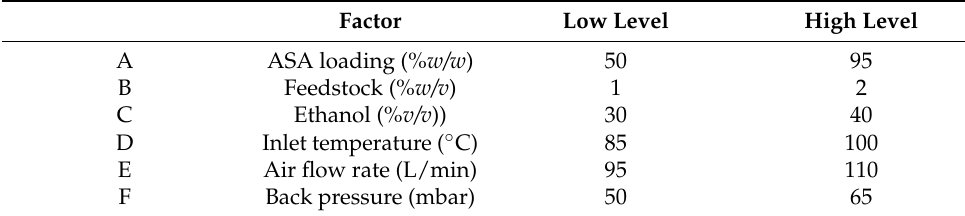
Table 1. The 2 6 − 2 fractional factorial design factors and